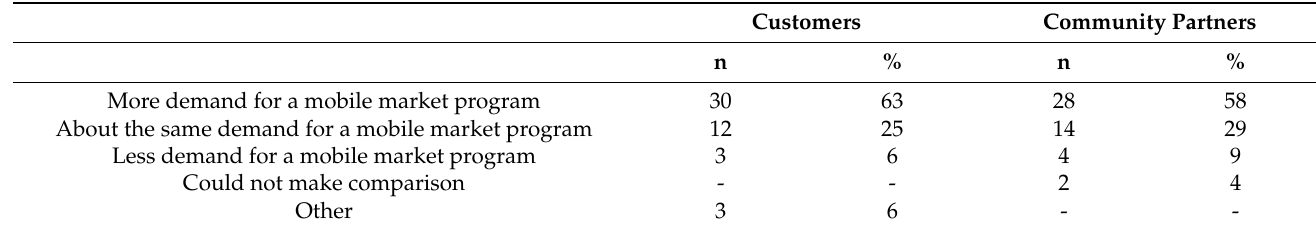
Table 2. Demand Change for a Mobile Market from Customers and Community Partners.